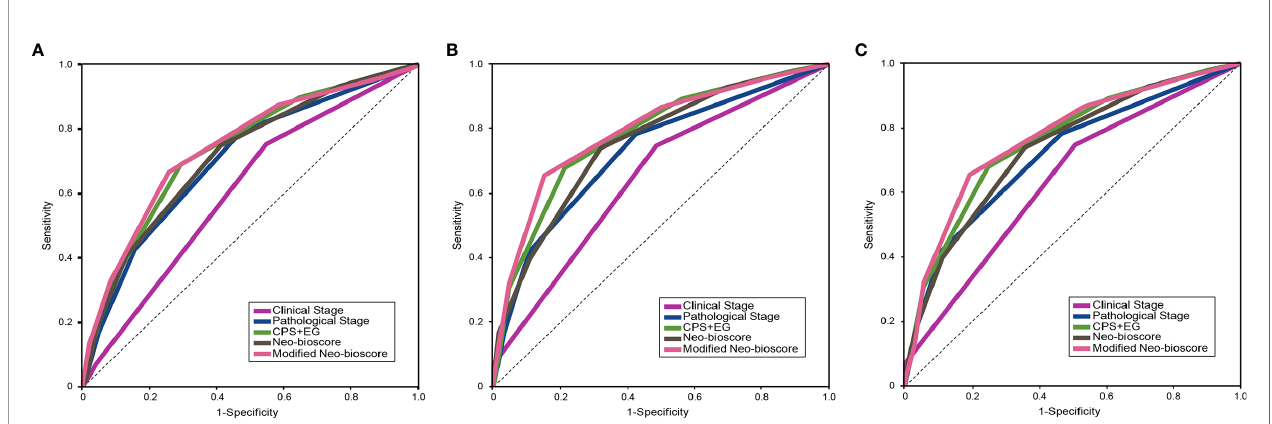
FIGURE 8 | Survival data assessed using the areas under the curves (AUCs) for the pretreatment clinical stage (CS), post-treatment pathological stage (PS), CPS + EG, Neo-Bioscore, and modi fi ed Neo-Bioscore. (A) Five-year disease free survival (DFS) assessed using AUCs in multiple staging systems; (B) Five-year disease speci fi c survival (DSS) assessed using AUCs in multiple staging systems; (C) Five-year overall survival (OS) assessed using AUCs in multiple staging systems.